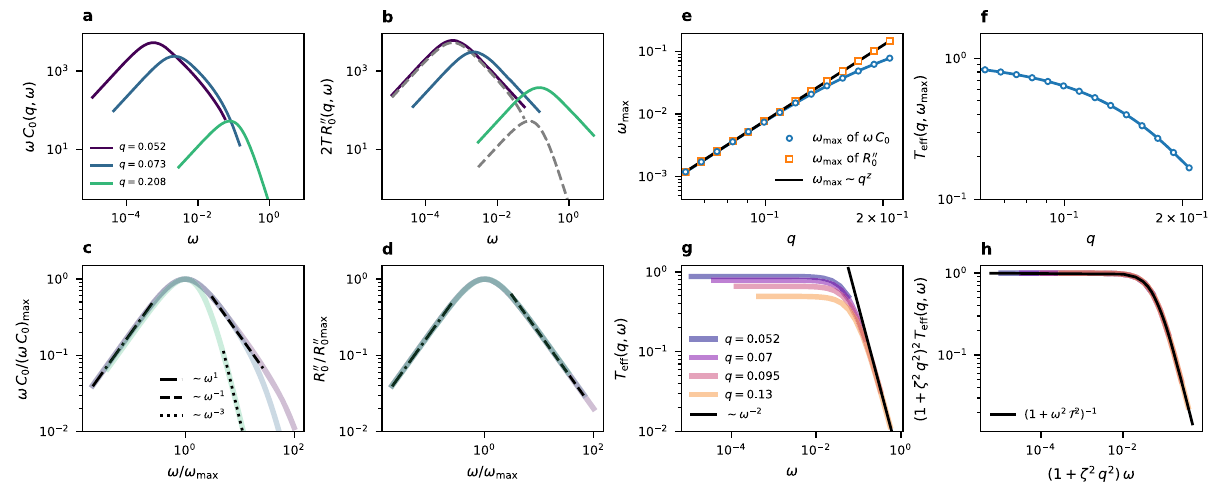
Fig. 4 Relaxation spectra and effective temperature in the colored-noise-driven fi eld theory. a Frequency-resolved correlation functions at various q -s (colored curves, see legend). b Frequency-resolved response function at the same q -s of a (colored curves, same legend as in a ). The correlation spectra for the highest and lowest wave-vectors in a are reproduced here as dashed lines to show that the deviation between response and correlation is stronger at high q . c Scaled correlation functions from a revealing a deviation from scaling in the high- q /high- ω regime. The asymptotic behaviors of these functions are highlighted by power-law fi ts (straight lines, see legend). d Scaled response functions from b . Differently from c a good collapse of the data is observed for the response and the asymptotic behaviors are evidenced by power law fi ts (straight lines, same legend as in c ). e Peak frequency of the correlator (circles) and of the response (squares) as a function of q (points are the results of analytic computation therefore they are reported without error-bars). The straight full line corresponds to the equation ω max ¼ γ q 4 with γ ≈ 10 2 (see text). f Effective temperature evaluated at the correlator peak-frequency as a function of q . (points are the results of analytic computation therefore they are reported without error-bars). g Frequency-resolved effective temperature in the low- q regime (colored curves), different colors indicate different q -values (see legend). The black line represents the power-law ω − 2 predicted by theory for the high- ω decay of T eff . h Data from g are scaled according to the